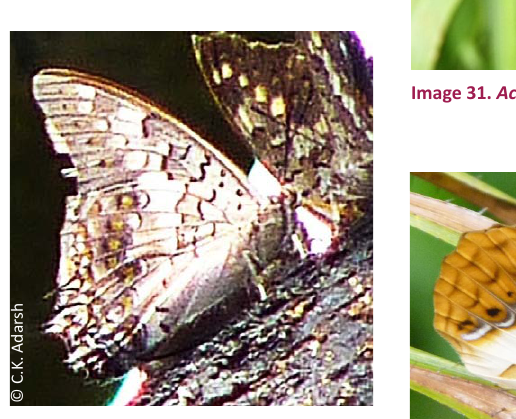
Image 30. Charaxes solon Black